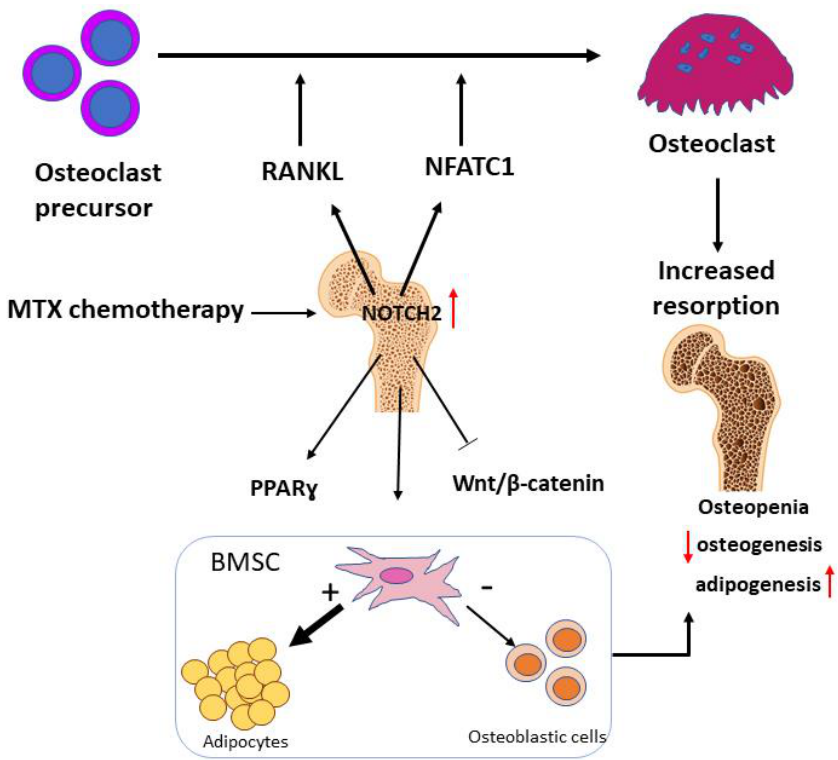
Figure 8. A schematic representation of the roles of the increased Notch2 activation in mediating MTX chemotherapy-induced bone loss and bone marrow adiposity. Increased expression and activation of Notch2 in rat metaphyseal bone following MTX treatment induces expression of receptor activator of NF- κ B ligand (RNAKL) and nuclear factor of activated T-cells 1 (NFATc1) that promote osteoclastogenesis and increase the density of osteoclasts on trabecular surfaces, resulting in increased bone resorption. Induction of Notch2 activity following MTX treatment increases the expression of adipogenic transcription factor peroxisome proliferator-activated receptor gamma (PPAR γ ) and suppresses Wnt/β-catenin signalling in bone which results in decreased osteogenic differentiation potential but increased adipogenic differentiation capacity of bone marrow stromal cells (BMSCs) and consequently reduced osteogenesis and accumulation of fat in marrow cavity: Induction; Inhibition; + Increase; − Decrease.